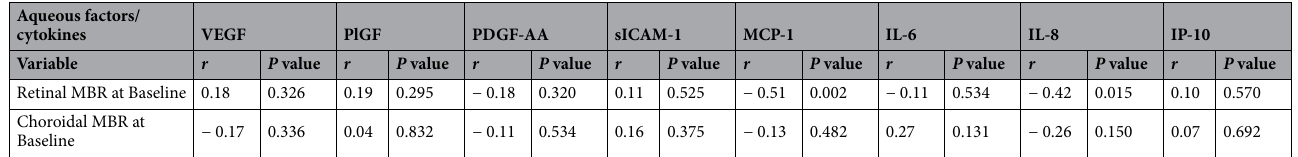
Table 3. Correlations between aqueous humor factors/cytokines and MBR at baseline. VEGF = vascular endothelial growth factor; PlGF = placental growth factor; PDGF = platelet-derived growth factor;